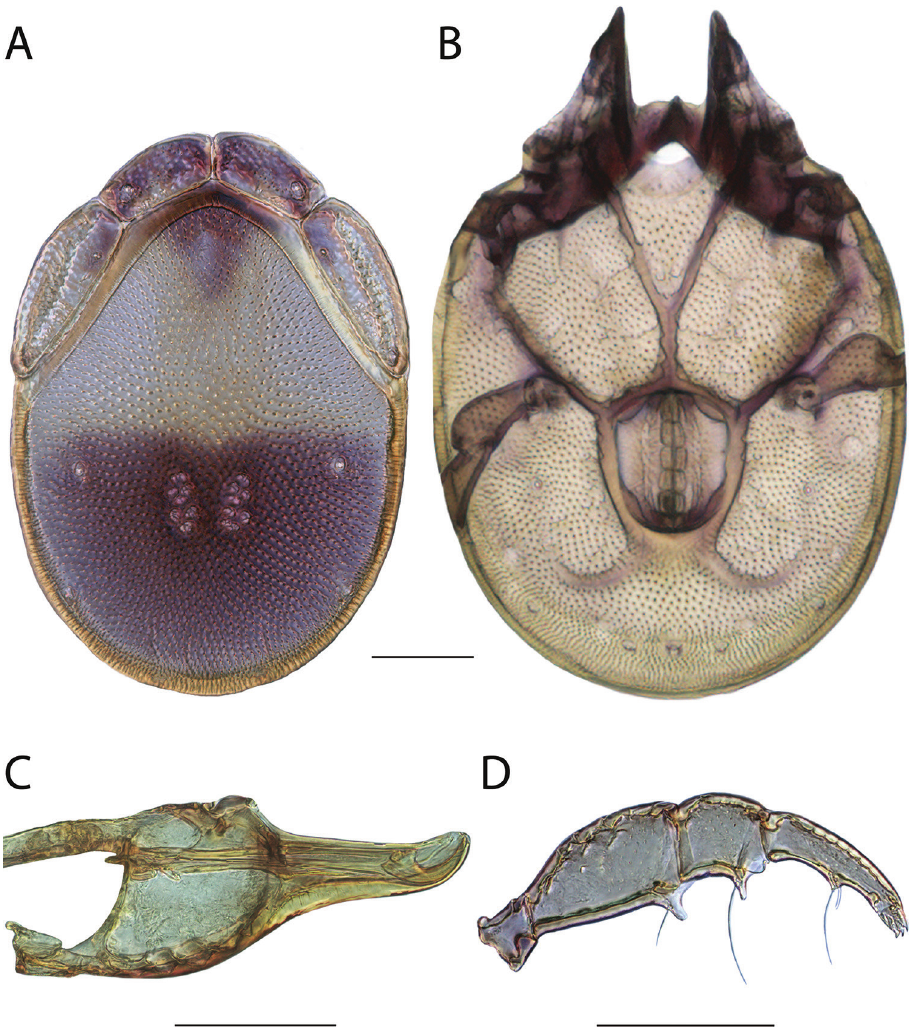
Figure 34. Torrenticola bondi sp. n. male: A dorsal plates B venter (legs removed) C subcapitulum D pe- dipalp (setae not accurately depicted). Scale = 100